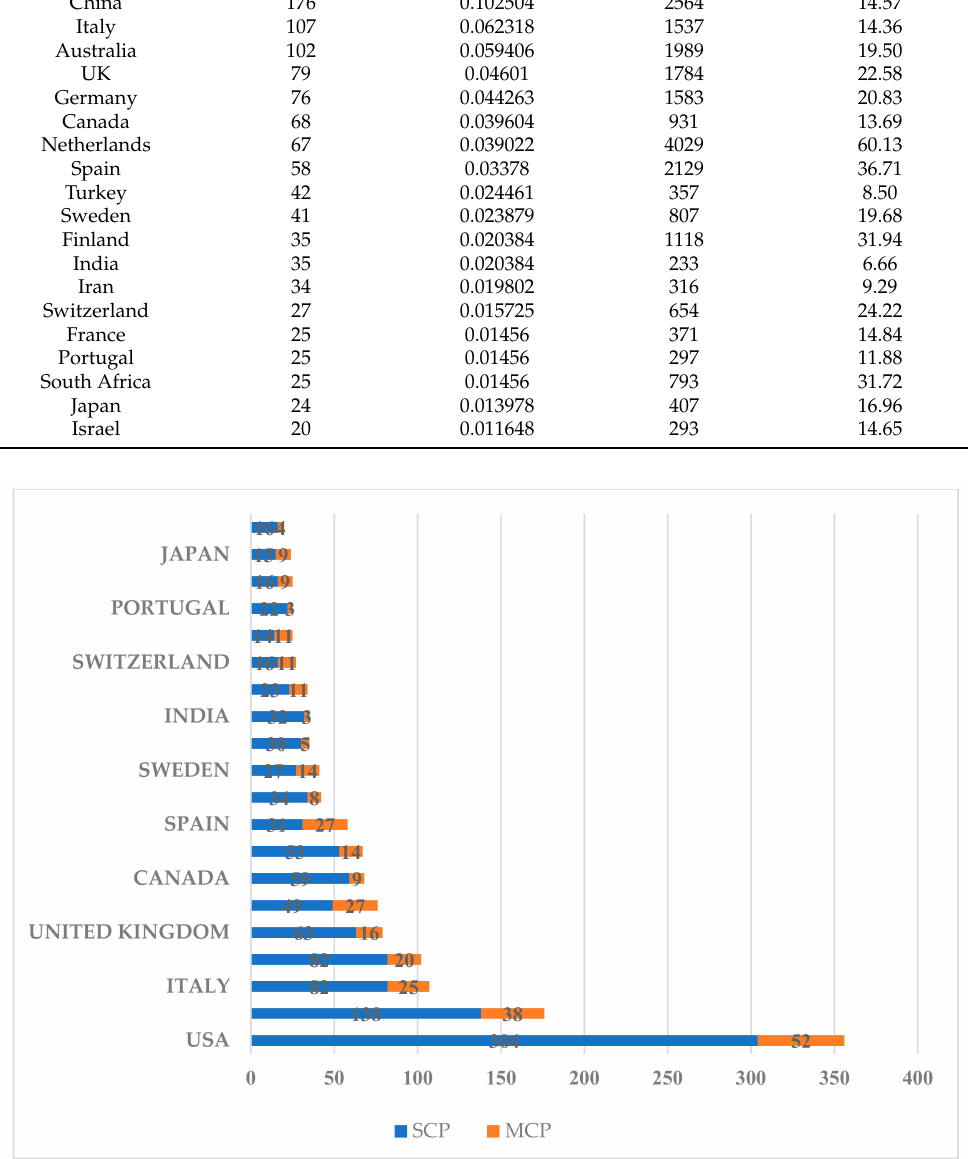
Figure 6. Top 20 producing countries and the corresponding authors in land use planning studies. The command vos.path = ““, type = “Vosviewer”, size = T, delete. multiple = T has been used to call the VOSviewer software application and produce cooperative maps of the 20 countries. In a collaboration map, the thicker a given connection line is between two countries, the stronger the cooperative relationship between the countries, and vice versa (Figure 7). As shown in Figure 7, the number of international cooperative